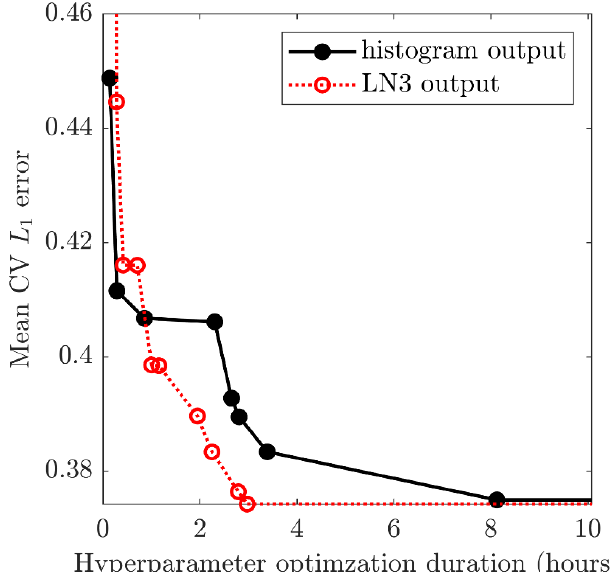
Figure A2. Neural network improvement of cross-validation (CV) performance with tuning effort. The best current CV-scores at any time during the tuning for the histogram output type (solid black line) and the LN3 output type (dotted red line). The first configuration for the LN3 output type NN provided a CV-score of 0.83; this point is omitted from the plot for clarity. After tuning, four NNs trained with the best configuration for each output type were available. Given an example and its MC PDF of TL, the L 1 error of the average of these four NN predictions will be no worse than the average of the four L 1 errors for each prediction. The mean L 1 errors across the training dataset for the tuned histogram and LN3 NNs decrease from averages of 0.3148 and 0.3330 to 0.3048 and 0.3253 when using the average of the NN predictions. Although making predictions takes four times as long, this improvement in performance may be worth the cost. Therefore, the final histogram NN and final LN3 NN analyzed in Section 3 are the models whose predictions are the average of the four trained CV NNs which correspond to the best attempted configuration for each respective output